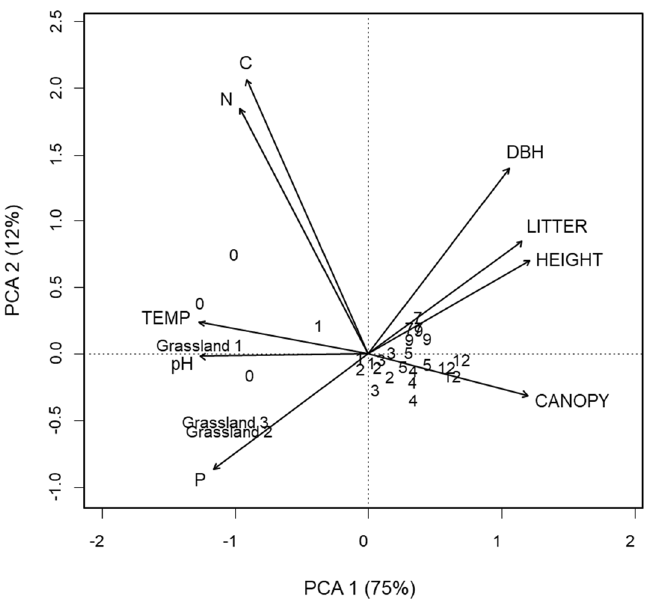
Figure 1. Biplot from principal component analyses (PCA) of environmental variables along eucalypt forest cycles and grassland sites. The first and second axes of the PCA are shown. The percentage of variance explained by each axis is given into brackets. CANOPY = canopy cover, LITTER = leaf litter depth, HEIGHT = eucalypt tree height, DBH = diameter at breast height, P = phosphorus content in soil, C = carbon content in soil, N = nitrogen content in soil, TEMP = temperature. Numbers represent the plantation